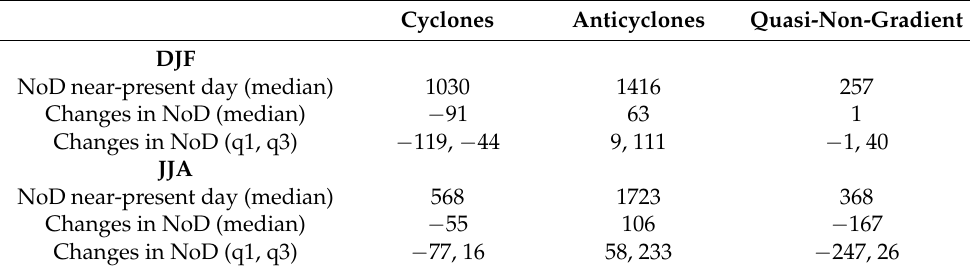
Table 3. Ensemble median of number of days (NoD) with cyclonic/anticyclonic/quasi-non-gradient flow in the near-present day (1971–2000; second row DJF, sixth row JJA), and ensemble median of the corresponding differences between future climate conditions (2041–2070, RCP8.5) and near- present day (1971–2000; third row DJF, seventh row JJA). Fourth and eighth rows show the 1st (q1) and 3rd (q3) quantile of changes in NoD. Cyclones Anticyclones Quasi-Non-Gradient 1416 257